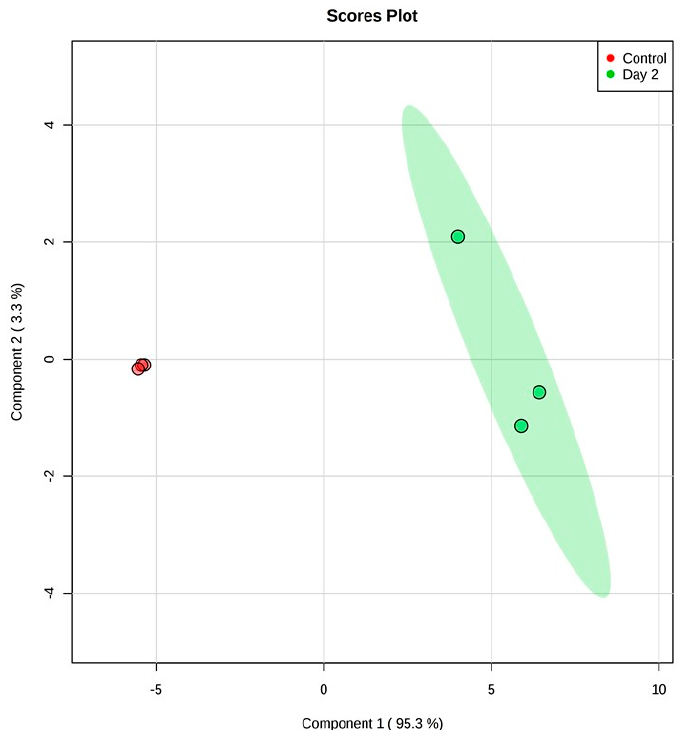
Figure 2. A partial least square-discriminant analysis (PLS-DA) score plot for metabolites analyzed by GC-MS for unfermented BSG (red) and fermented BSG samples (green), with a 95% confidence interval. Each dot represents all of the metabolites detected in each replicate.